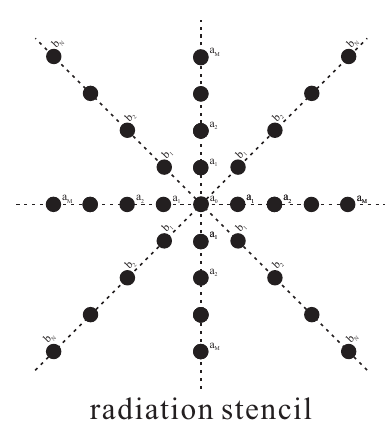
Figure 1. Schematic diagram of the new stencil, where the new radiation stencil is composed of a standard cross-stencil and a rotated cross-stencil of ( π /4 )